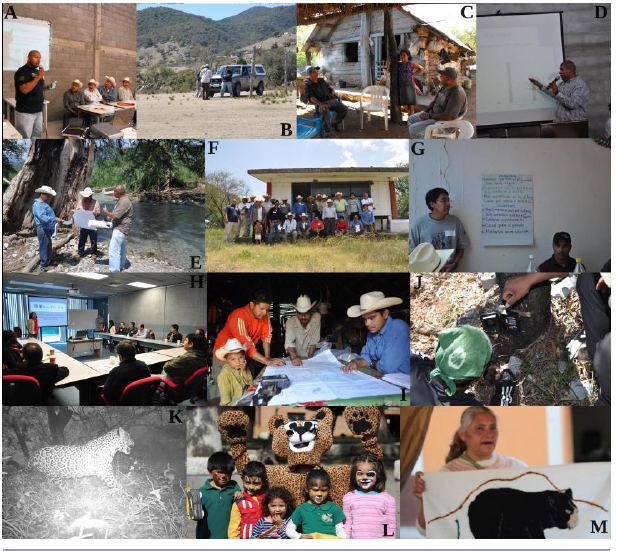
Fig. 4 . Photos of the case study work. (A) presentation of the project to the Livestock Associations; (B) and (C) collection of data with local people (survey); (D) presenting the results to the Livestock Associations; (E) inviting people to participate in workshops aimed at finding solutions; (F) participants of a workshop in an ejido; (G) participants presenting proposals to mitigate the conflict; (H) workshop with governmental authorities in the capital city of Nuevo León; (I) planning with local people the biological monitoring of medium and large mammals; (J) installation of phototrapping cameras; (K) first images collected; (L) activities with children; and (M) woman who won the crafts contest at the Tiger